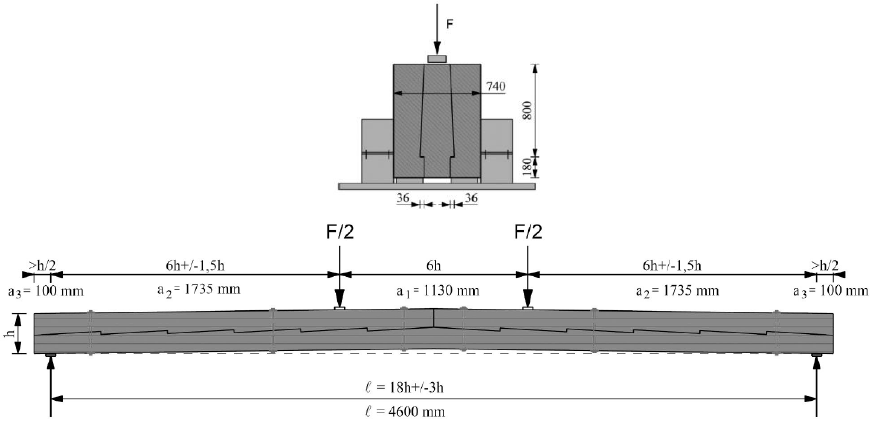
Figure 7. Model of a composite beam connected with a stop-splayed scarf joint and models used for testing of the joint itself and the element as a whole, image adapted from [17] with permission.